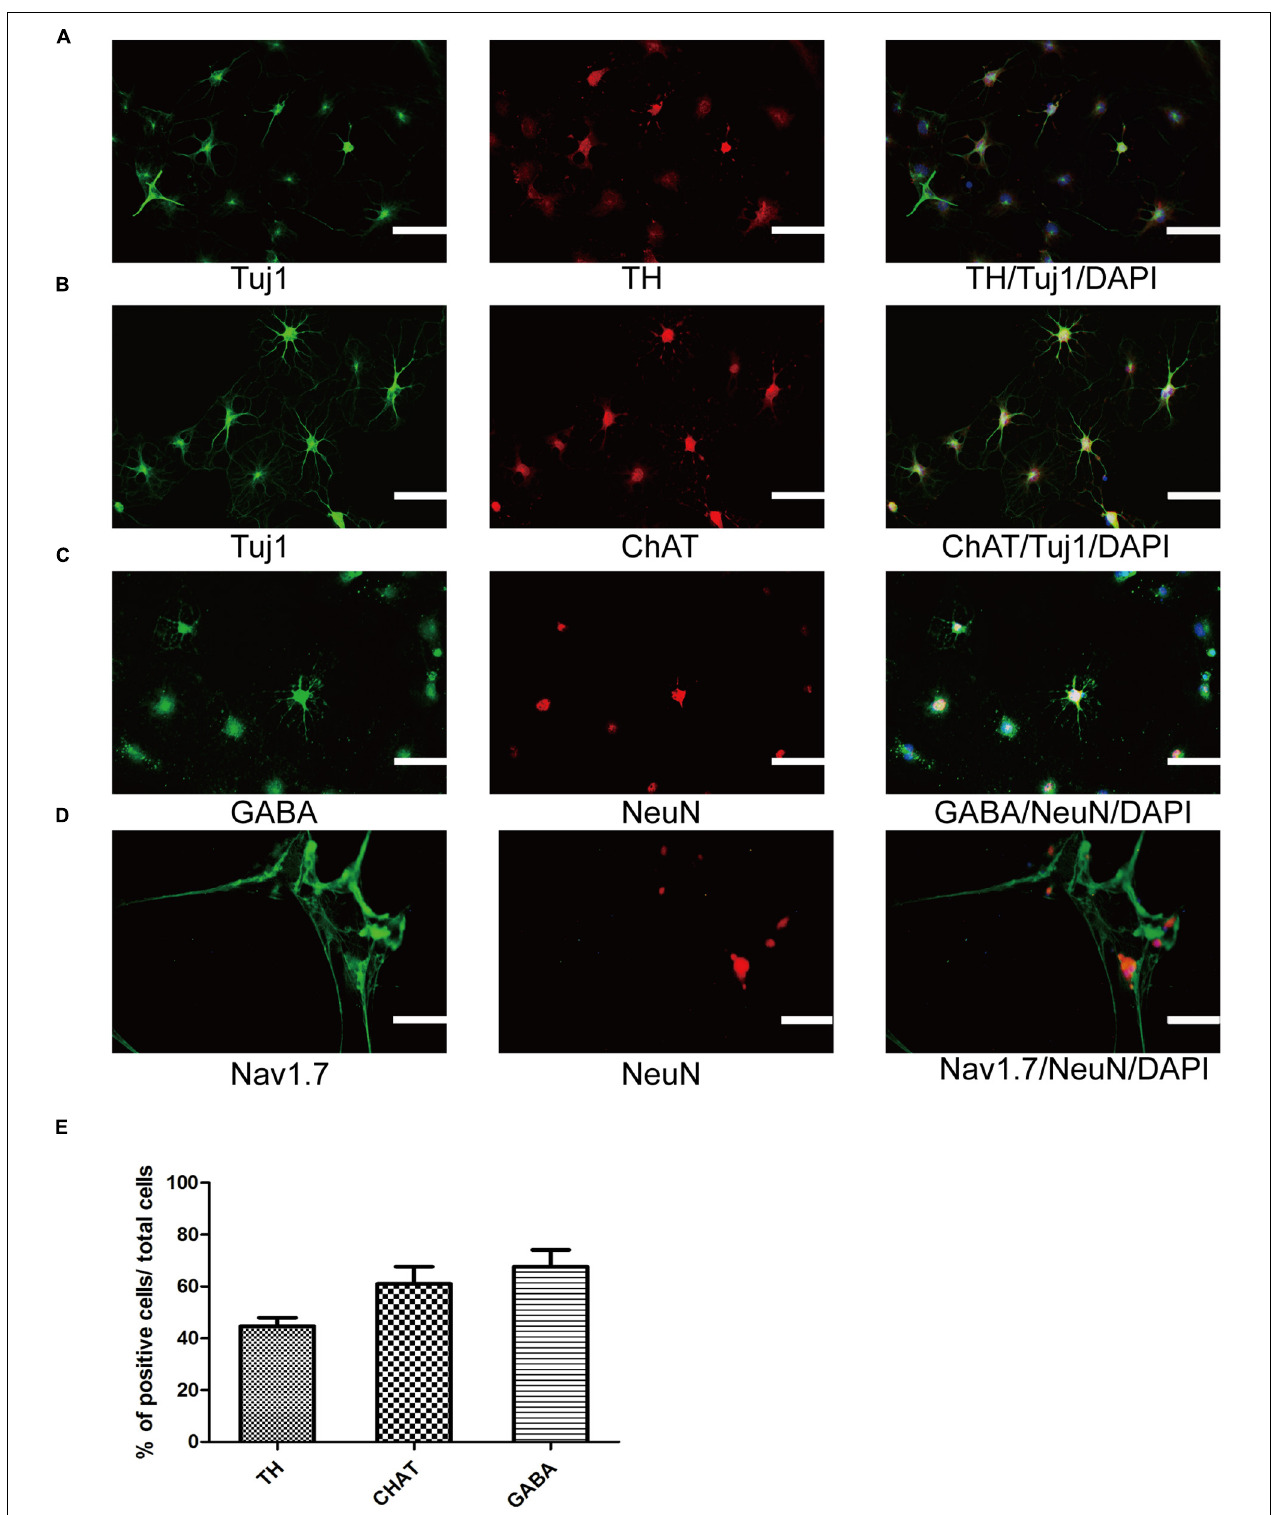
FIGURE 4 | Differentiation and maturation of functional neurons from SMSINS. (A–C) Immunostaining of TH (Red), ChAT (Red), GABA (Green), Tuj1 (Green), and NeuN (Red), using antibodies labeled underneath the image. Nuclei were counterstained with DAPI (blue). (D) Sodium channels determined by immunostaining with Nav1.7 (Green). Nuclei were counterstained with DAPI (blue). (E) Quantification of TH dopaminergic neurons, ChAT cholinergic neurons and GABA GABAergic neurons differentiated from SMSINS. Data are represented as the mean ± SEM. Scale bars: 100 µ m (A–D) .